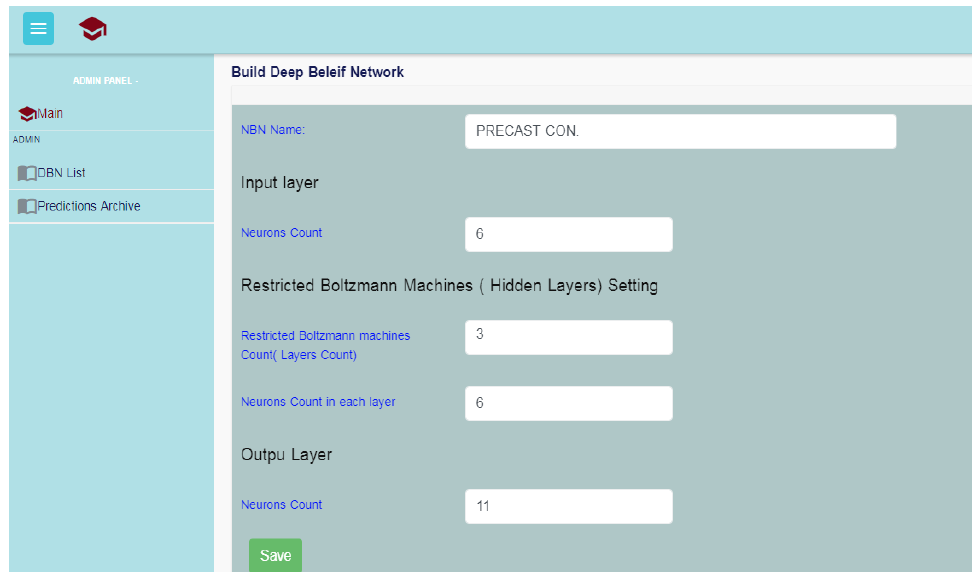
Figure 2. Setting the required parameters for creating the DBN in the interface program.